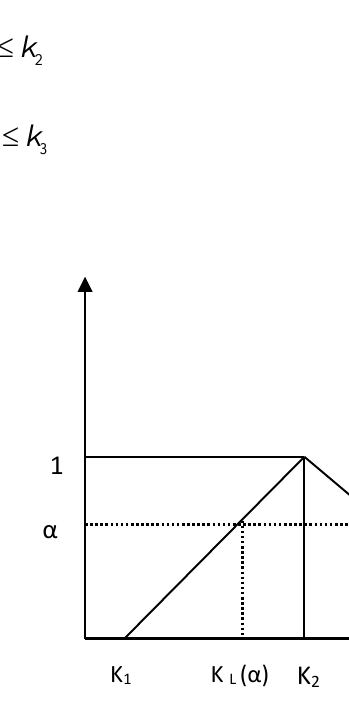
Fig. 1. α-cut of a triangular fuzzy